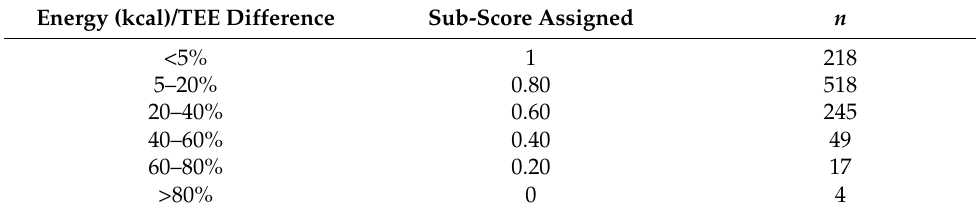
Table A3. Energy penalties